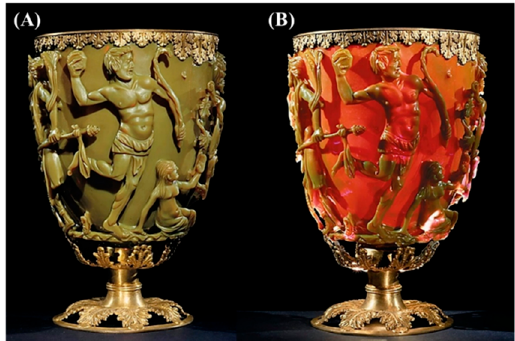
Figure 3. The Lycurgus cup. The glass appears green in reflected light ( A ) and red-purple in transmitted light ( B ). Reproduced with permission from reference [10].